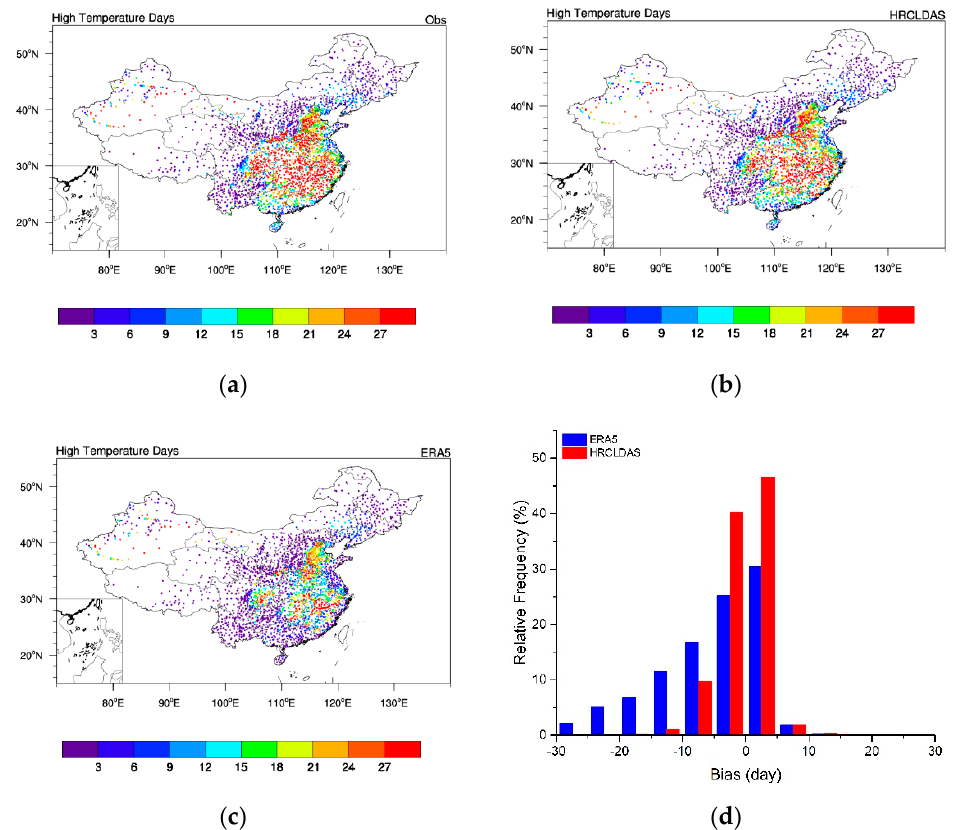
Figure 4. ( a ) Spatial distribution of high temperature (>35 °C) days from 1 June to 31 August in 2018 for observations; ( b ) spatial distribution of high temperature (>35 °C) days from 1 June to 31 August in 2018 for HRCLDAS; ( c ) spatial distribution of high temperature (>35 °C) days from 1 June to 31 August in 2018 for ERA5; ( d ) frequency distribution of bias of high temperature (>35 °C) days from 1 June to 31 August in 2018 for ERA5 and HRCLDAS.